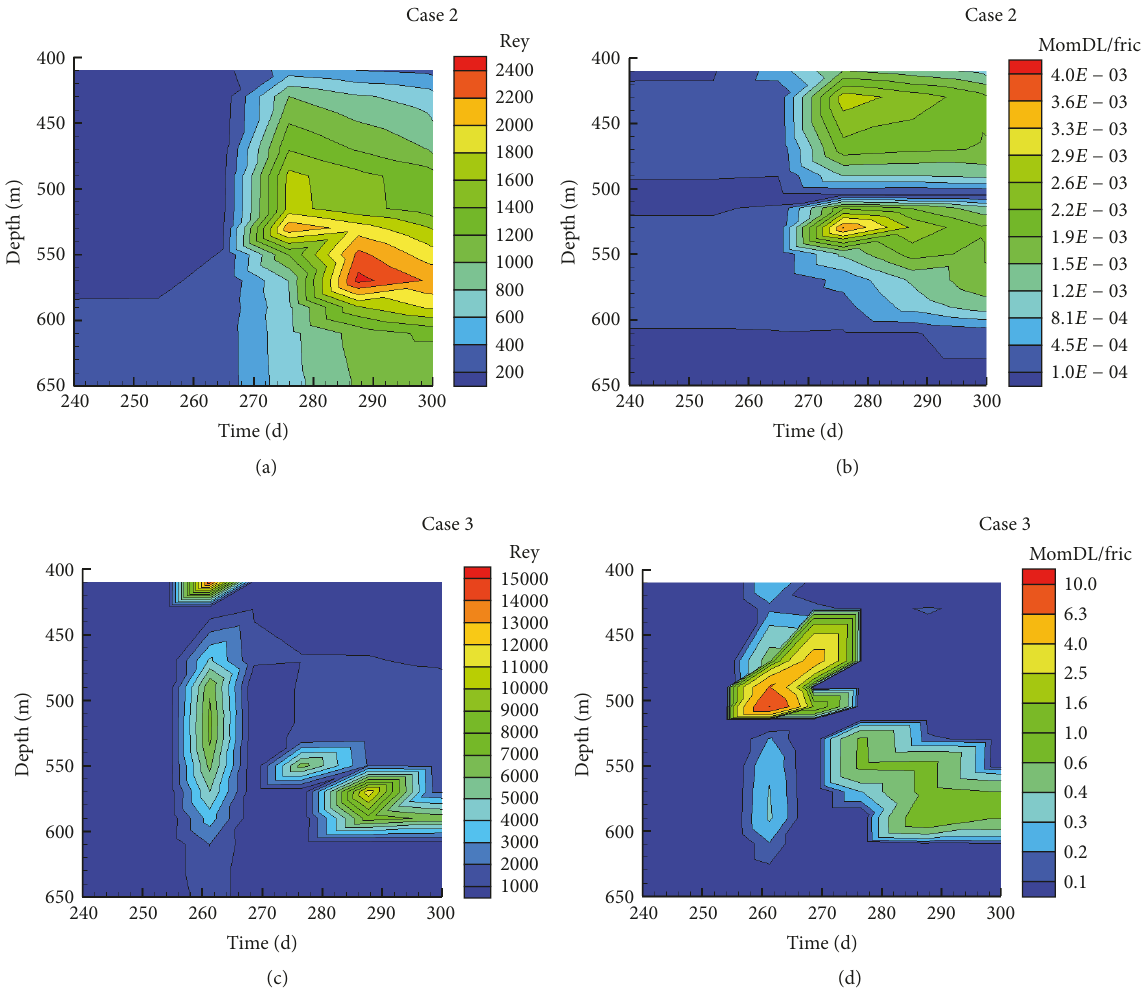
Figure 12: Changes of Reynold number and momentum/friction ratio in the fracture of Case 2 and Case 3 when CO 2 breakthrough occurs.